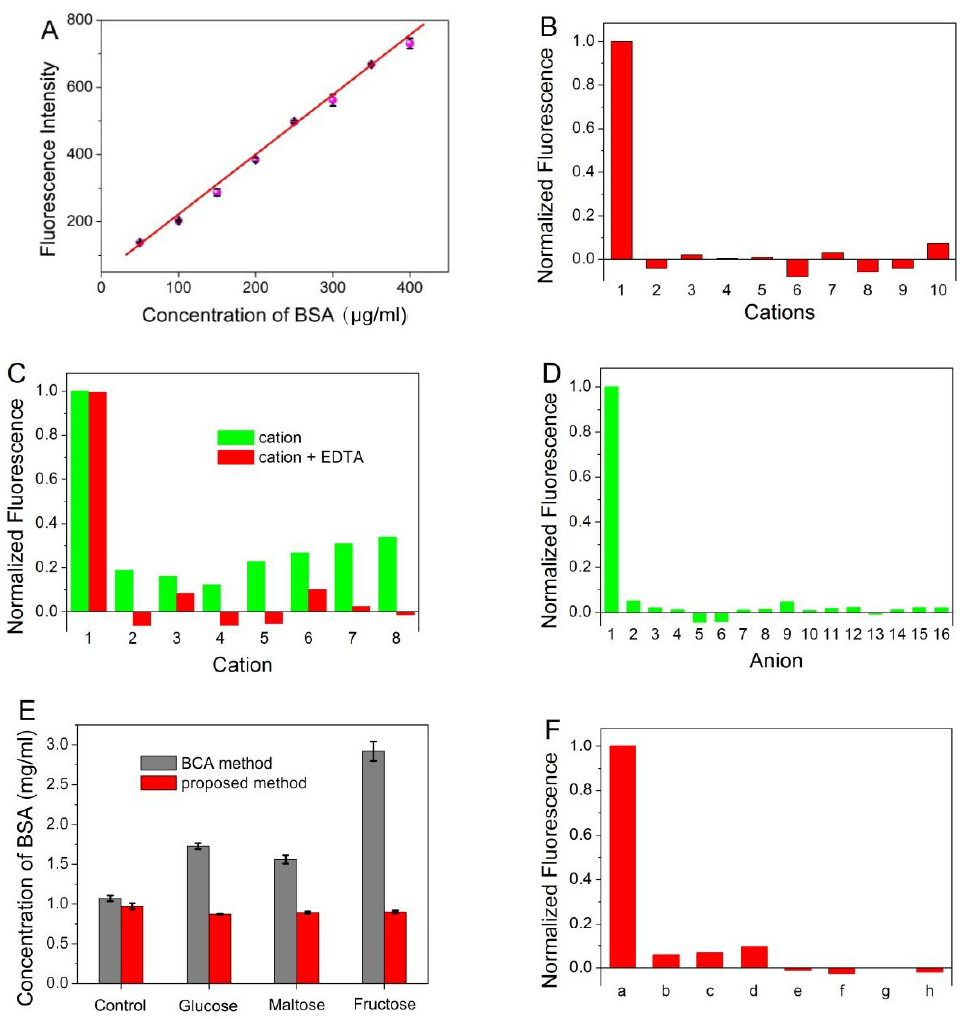
Figure 4. ( A ) The plot of the fluorescence intensity of ATT-AuNCs versus the concentration of BSA. Error bars represent the standard deviations across three repetitive experiments. ( B ) Fluorescence response of ATT-AuNCs to different cations. Samples marked 1 to 10 correspond to BSA (250 μg/mL), Ag + , Cr 3+ , K + , Na + , Hg 2+ , NH 4+ , Fe 3+ , Cu 2+ , and Mn 2+ , respectively. The concentration of each cation was 2 mM. ( C ) Fluorescence response of ATT-AuNCs to different cations in the presence of 2.5 mM of EDTA. Samples marked 1 to 8 correspond to BSA (250 μg/mL), Ni 2+ , Ba 2+ , Pb 2+ , Zn 2+ , Mg 2+ , Ca 2+ , Al 3+ , respectively. The concentration of each cation was 2 mM. ( D ) Fluorescence response of ATT-AuNCs to different anions. Samples marked 1 to 16 correspond to BSA (250 μg/mL), HCOO ‒ , NO 2‒ , NO 3‒ , CN ‒ , IO 3‒ , PO 43‒ , SO 42‒ , Br ‒ , SCN ‒ , I ‒ , BrO 3‒ , ClO 4‒ , F ‒ , Cl ‒ , and CO 32‒ , respectively. The concentration of each anion was 1 mM. ( E ) The detection results of BSA in the presence of different reducing sugar (5 M). Error bars represent the standard deviations across three repetitive experiments. ( F ) Fluorescence response of ATT-AuNCs to (a) 250 μg/mL BSA, (b) 0.5% SDS, (c) 20 mM creatine, (d) 0.5% Tween 20, (e) 150 mM urea, (f) 5% ethanol, (g) 20 mM EDTA, and (h) 0.5% TritonX-100. The normalized fluorescence intensity is calculated by (I − I 0 )/(I BSA − I 0 ), where I 0 , I, and I BSA is the fluorescence intensity of ATT-AuNCs, ATT-AuNCs + interferent, ATT-AuNCs + BSA, respectively.